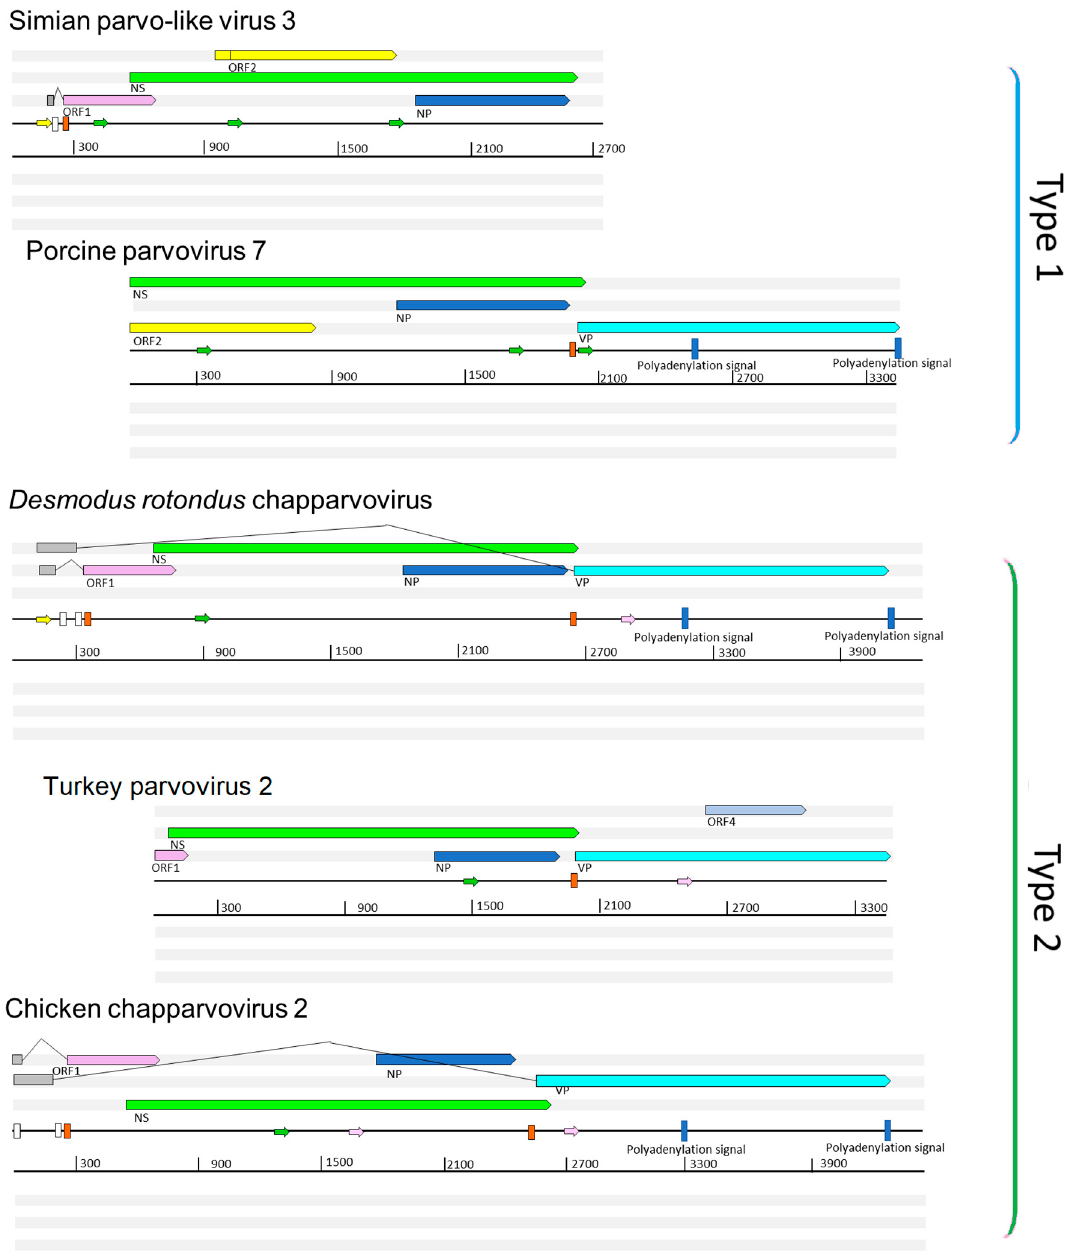
Figure 1. Representative complete coding sequence and partial genome organizations of the two distinct types of exogenous amniote chapparvoviruses (ChPVs). Open reading frames (ORFs) are represented by rectangular arrows, colored according to homology. Splice donor sites are marked by white-colored bars, acceptor sites by orange-colored bars. Blue-colored bars show predicted polyadenylation signals. Small arrows show predicted promoters and are colored according to prediction score ( > 0.95 = green; 0.9–0.95 = pink: < 0.9 = yellow). Grey boxes indicate regions inferred to be transcribed but not translated. Note: ORF4 is unique to turkey parvovirus and is not found in other avian type 2 ChPVs, such as chicken ChPV2.